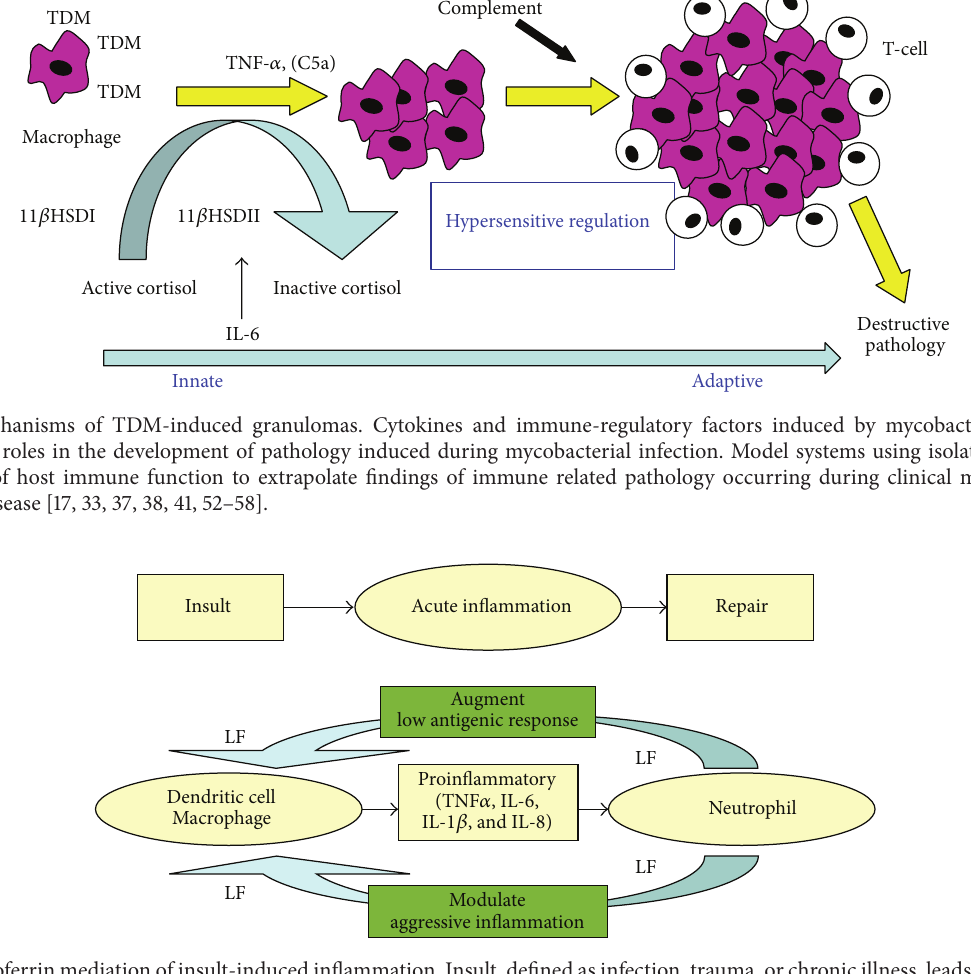
Figure 2: Lactoferrin mediation of insult-induced inflammation. Insult, defined as infection, trauma, or chronic illness, leads to activation of macrophage and dendritic cells. Activated neutrophils degranulate at the site of injury and release massive amounts of lactoferrin. Lactoferrin, in turn, can either augment low level responses or modulate overaggressive cytokine activity. Both effects serve to control inflammation to assist with tissue repair after insult (modified from